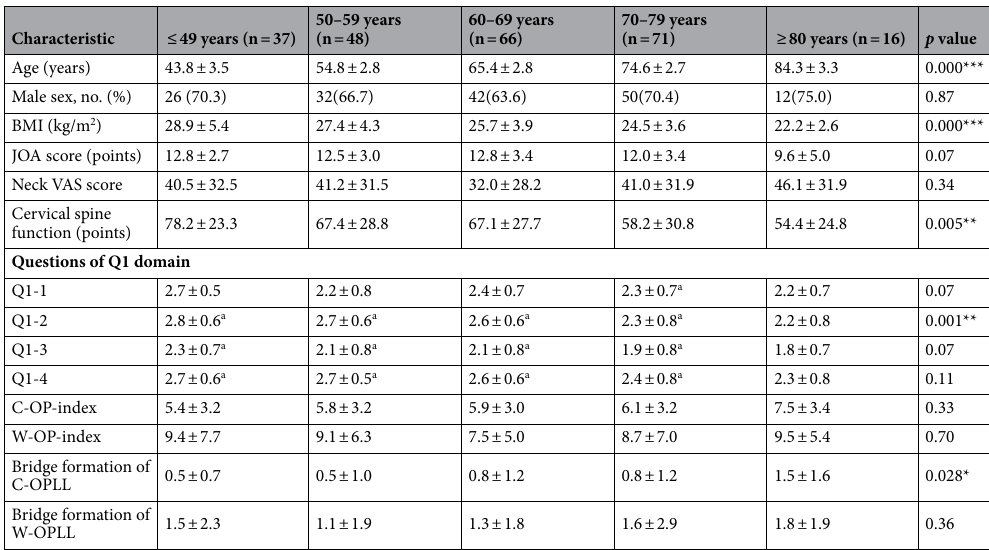
Table 3. Age-related changes in parameters. Data are presented as mean ± standard deviation. BMI body mass index; JOA Japanese Orthopaedic Association; VAS visual analog scale (100-mm). Q1 domain cervical spine function domain of the Japanese Orthopaedic Association Cervical Myelopathy Evaluation Questionnaire; C , cervical; W , whole spine; OP-index ossification index for OPLL; bridge formation ossified lesions forming a bridge with the posterior border of the adjacent vertebral body. a Significant differences were found among the questions in each age group (all p < 0.05). * p < 0.05; ** p < 0.01; *** p < 0.001.